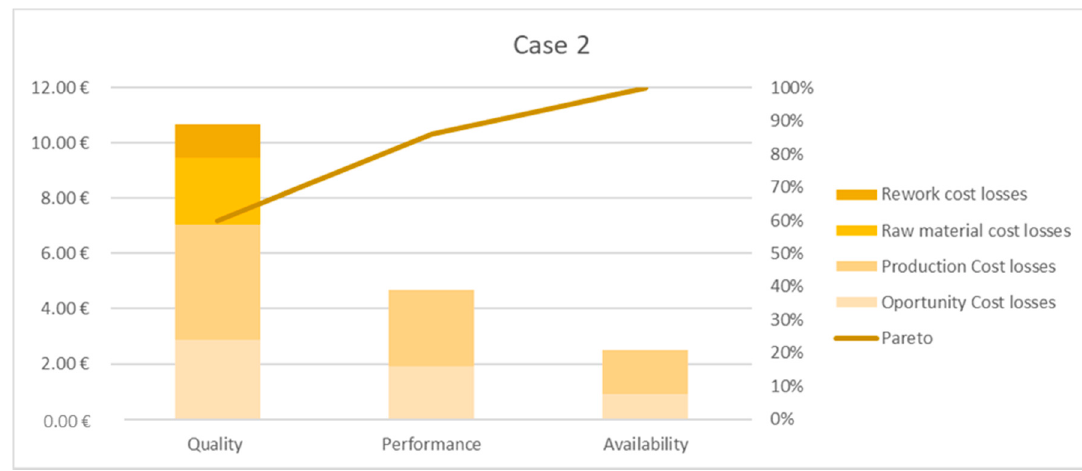
Figure 7. Cost loss indicator (CLI) case 1 diagram.